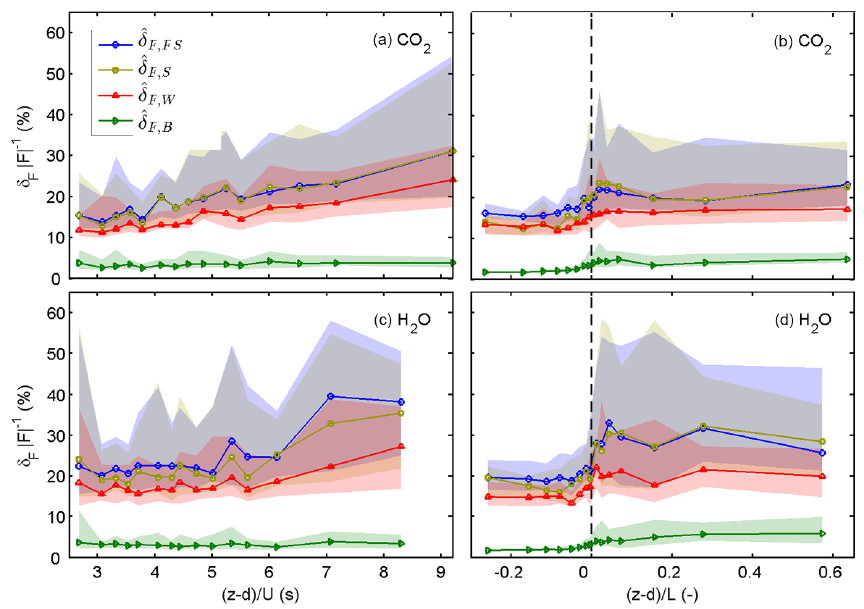
Figure 4. Dependence of relative errors on (z − d)U − 1 and (z − d)L − 1 at the SMEAR II forest site. Data were binned before plotting (symbols connected by lines: medians; areas: interquartile range). For (a) and (c) only periods with | (z − d)L − 1 | <0.1 were used, and for (b) and (d) periods when 2ms − 1 < U <4ms − 1 were selected.